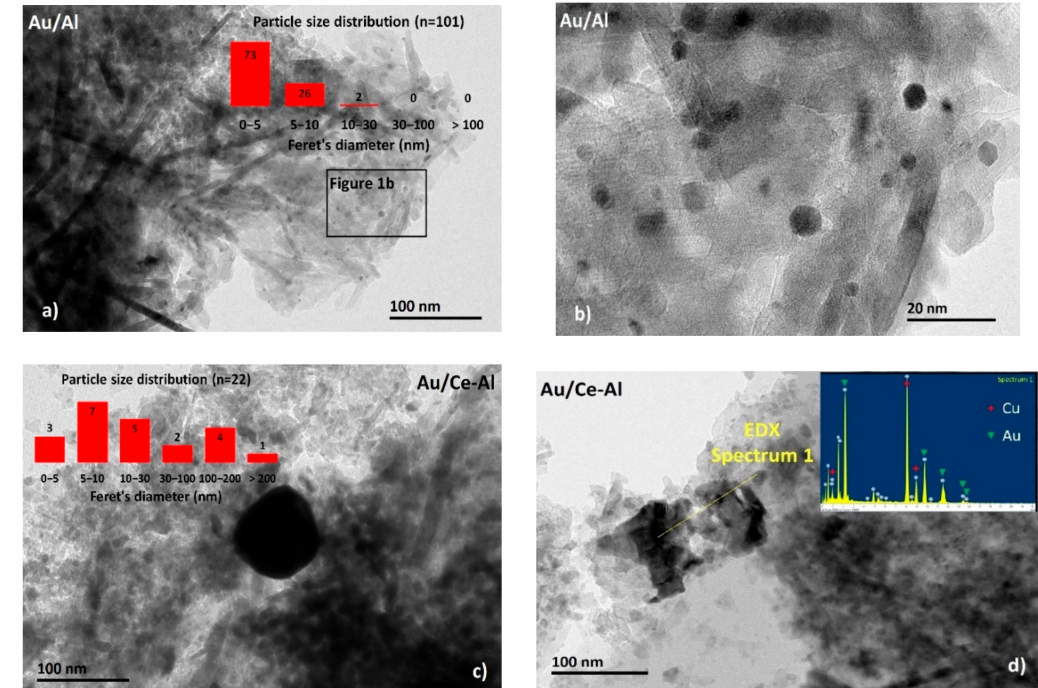
Figure 1. High-resolution transmission electron microscope (HR-TEM) images of the Au / Al 2 O 3 and Au / CeO 2 -Al 2 O 3 catalysts: ( a ) corresponding particle size distribution (PSD) data of Au / Al 2 O 3 , ( b ) example particles in sizes below 10 nm shown with the magnification of the inset in Figure 1a, ( c ) corresponding PSD data of Au / CeO 2 -Al 2 O 3 , and ( d ) an energy-dispersive X-ray (EDX) spectrum from the agglomerate (Cu peaks in the spectrum originate from the used sample